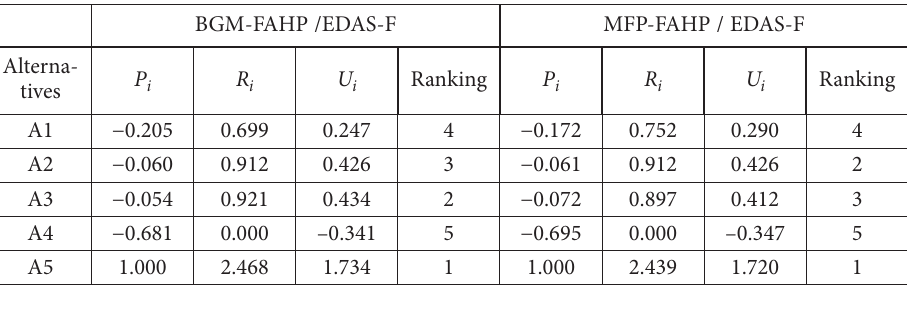
Table 11. Results of the integrated FAHP/ARAS-F method